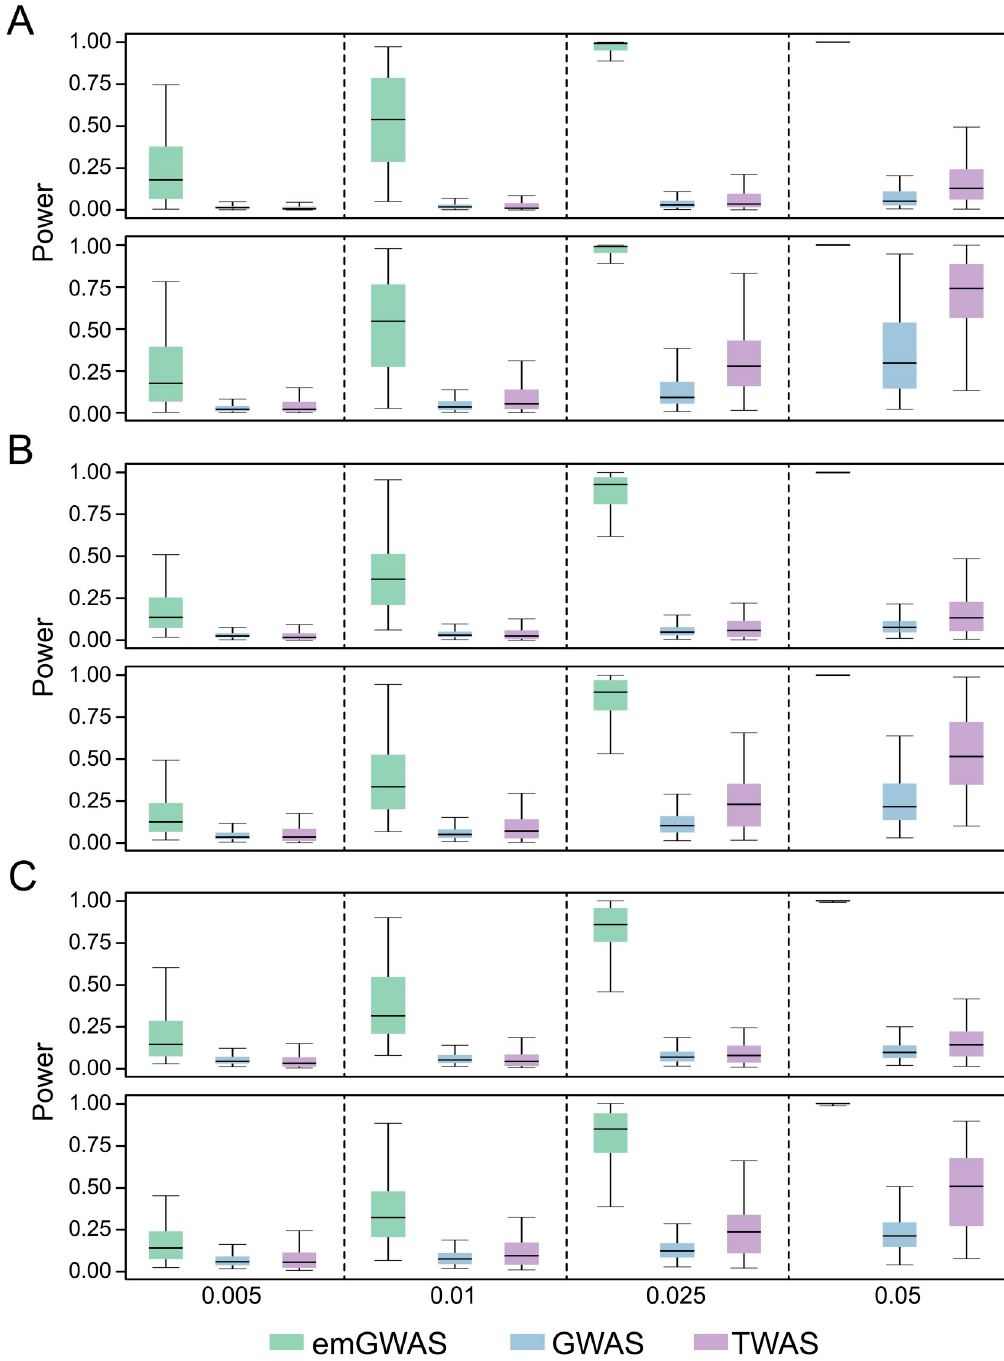
Fig 2. Causality scenario when expression heritability is high and PVX is low. The PVX is 0.005, 0.01, 0.025, and 0.05 in the four columns as indicated by the X-axis labels. The number of genes contributing to phenotype for (A), (B) and (C) are 4, 9, and 13 respectively. The expression heritability for the top and bottom rows of (A), (B) and (C) are 0.1 and 0.3 respectively. The number of causal variants per gene is randomly sampled from the interval [4,9].